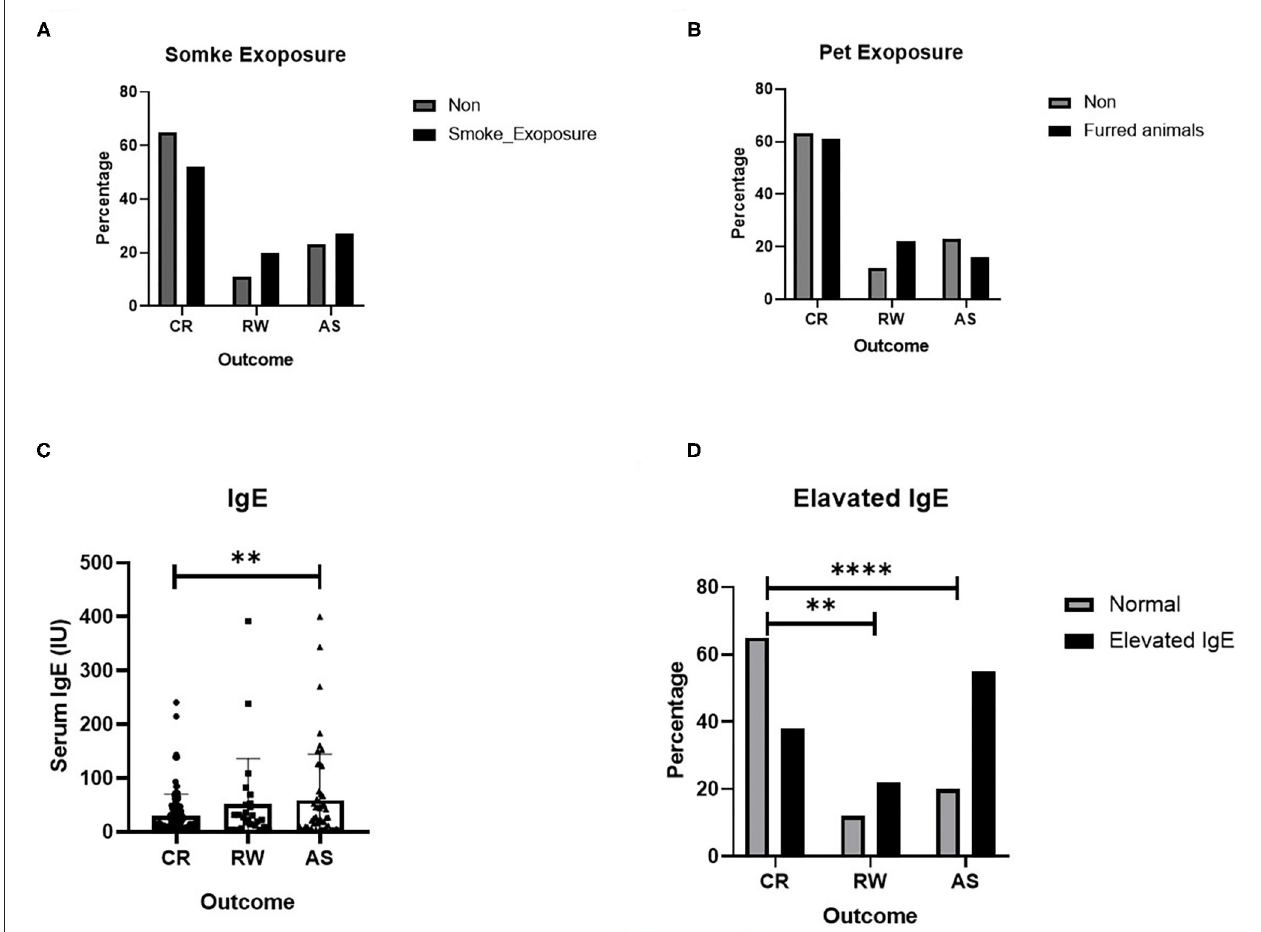
FIGURE 1 | Several risk factors for recurrent wheezing and asthma. (A) Effect of smoke exposure; (B) Effect of Pet exposure; (C) Serum IgE level; (D) Effect of elevated IgE. The data are expressed as the mean ± SD or n (%). ** P -value < 0.01, **** P -value <